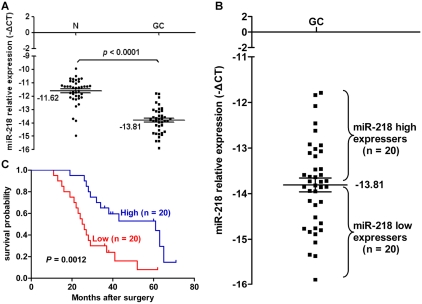
miR-218 expression in clinical GC specimens.(A) miR-218 was differentially expressed between GC and the corresponding non-neoplastic mucosa (N). The term -ΔCt was used to describe the expression level of miR-218 (−ΔCt = CtU6−CtmiR-218). A significant difference was detected in the mean value of miR-218 expression between these two groups (P<0.0001, t = 10.62, paired t-test). (B) The same GC samples as in (A) were divided into two groups according to the mean expression of miR-218 (mean, −13.81). Cases with levels of miR-218 below the mean were miR-218 low expressers (n = 20), and those with levels of miR-218 above the mean were miR-218 high expressers (n = 20). (C) Kaplan–Meier survival curve and log-rank test for GC patients between high and low miR-218 expressers. miR-218 expression demonstrated a significant relationship with patient survival (log-rank, P = 0.0012).